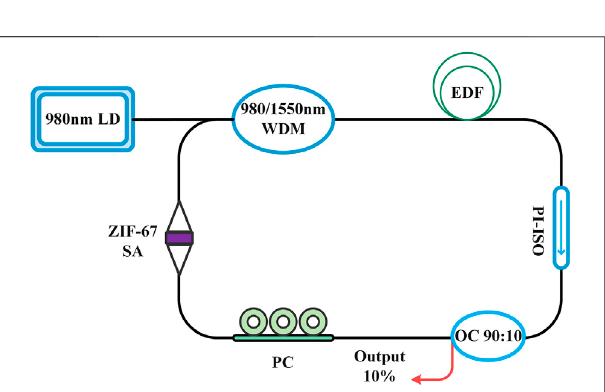
FIGURE 4 | Experimental schematic of the ZIF-67-based Er 3+ -doped fi ber laser.